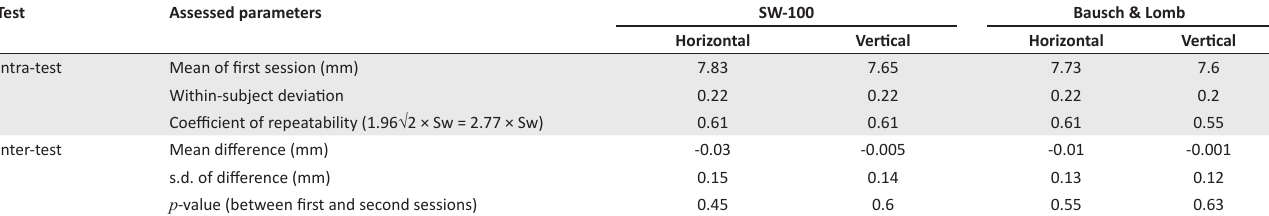
TABLE 2: Intra-test ( N = 80) and inter-test ( n = 40) variability of the curvature results obtained with the SW-100 and Bausch & Lomb keratometers. Test Assessed